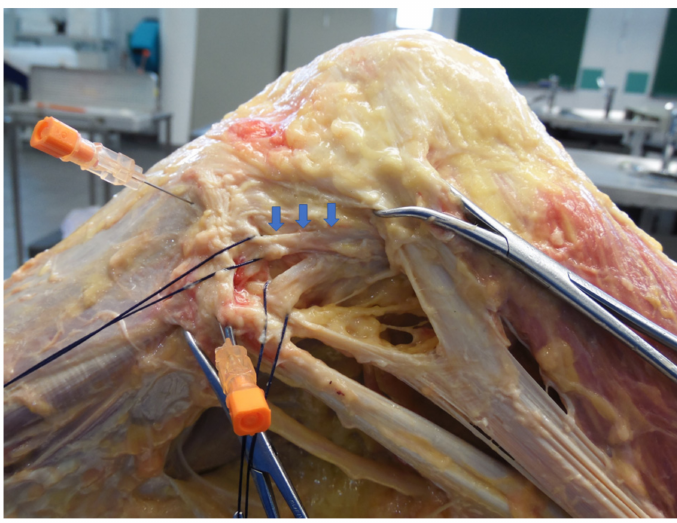
Figure 1. Dissection and isolation of the ALL (blue arrow) in a fresh-frozen cadaveric